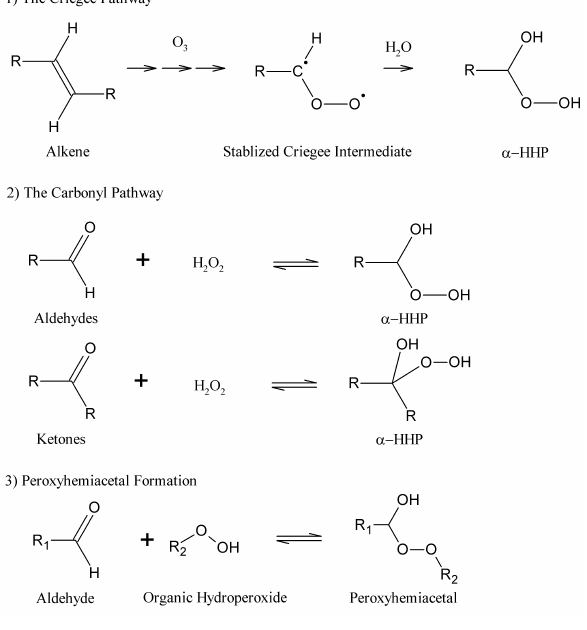
Fig. 1. Two aqueous-phase pathways of α -hydroxyhydroperoxide ( α -HHP) formation: (1) The Criegee pathway, (2) the carbonyl path- way, and a related reaction (3) peroxyhemiacetal